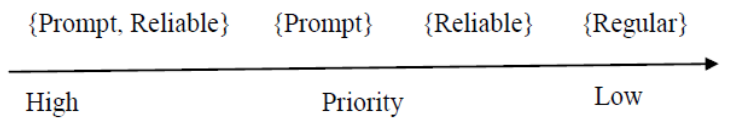
Figure 2. Priority scale for different service